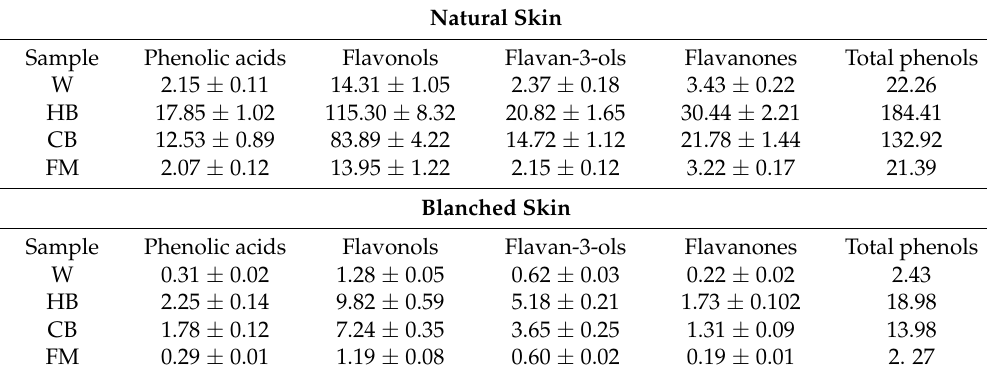
Table 2. Baseline polyphenols content of natural skins and blanched skins in water (W); home-made biscuits (HB); crisp-bread (CB) and full-fat milk (FM). Values were given as µ g/g and represent averages ( ± SD) of triplicate